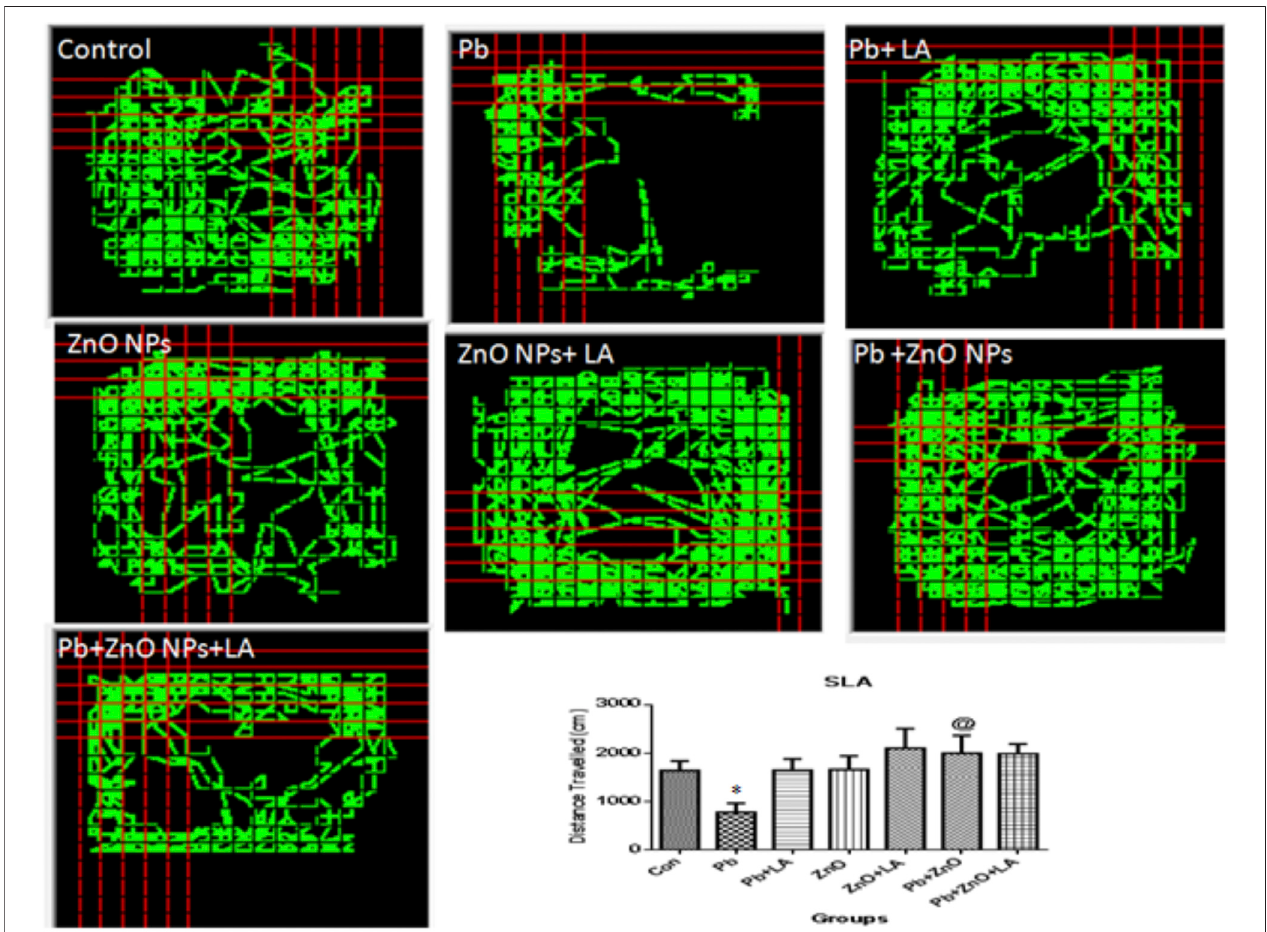
FIGURE3| LocomotoractivityinratsusingtheOptovarimaxapparatus.Allthevaluesareexpressedasmean ± SEM(n (cid:2) 5).* p < 0.05vs.control; @ p < 0.05vs.lead.